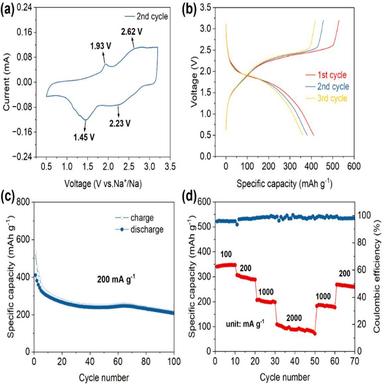
(a) CV profiles of NVP//Co0.11Ni0.89S@NC obtained at a scan rate of 0.2 mV s−1 at the second cycle; (b) Galvanostatic charge and discharge voltage profiles of NVP// Co0.11Ni0.89S@NC at 100 mA g−1; (c) Cycling performance of NVP//Co0.11Ni0.89S@NC at 200 mA g−1; (d) Rate capacity of NVP//Co0.11Ni0.89S@NC.